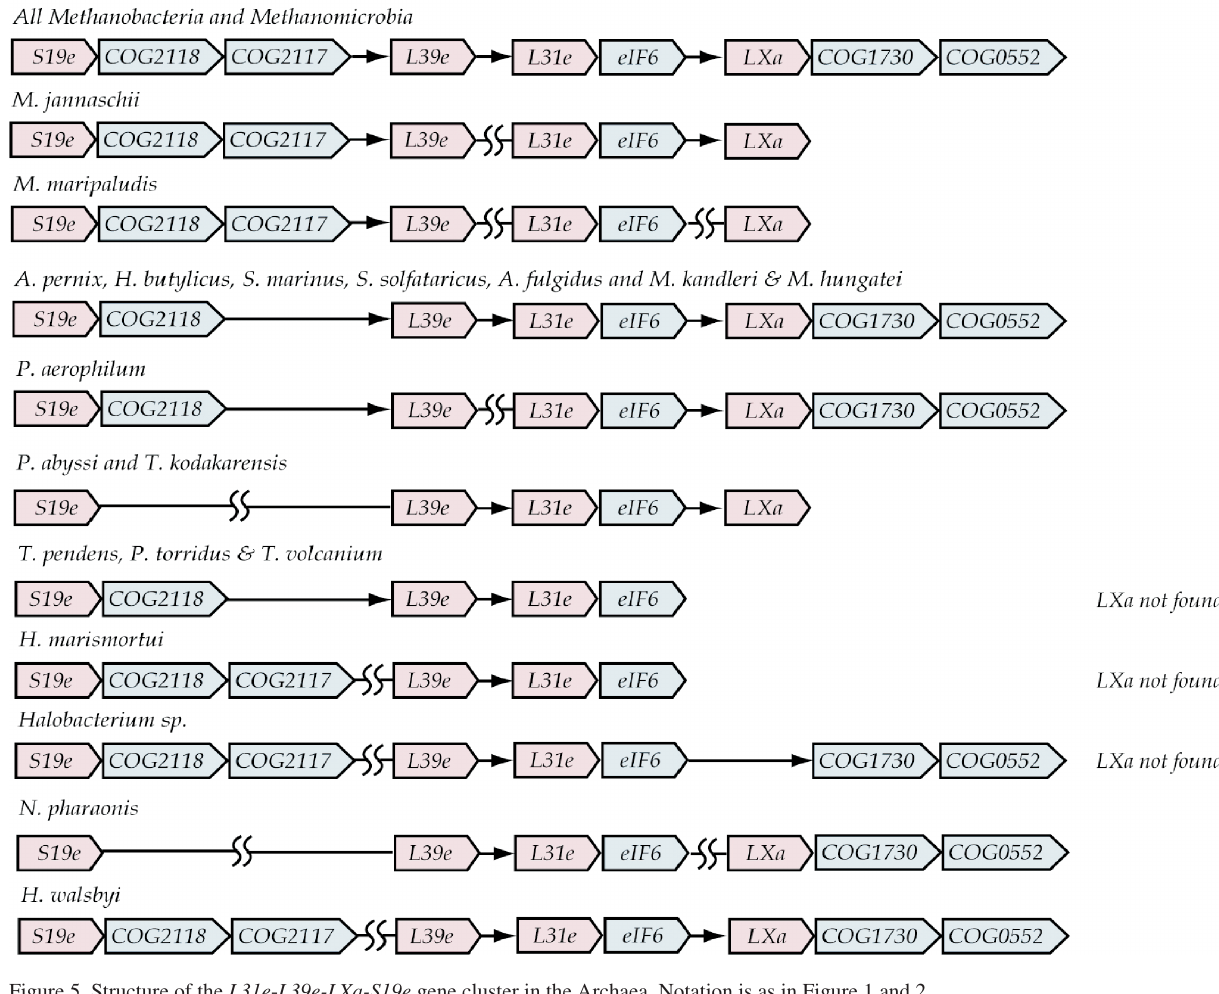
Figure 5. Structure of the L31e - L39e-LXa-S19e gene cluster in the Archaea. Notation is as in Figure 1 and 2.